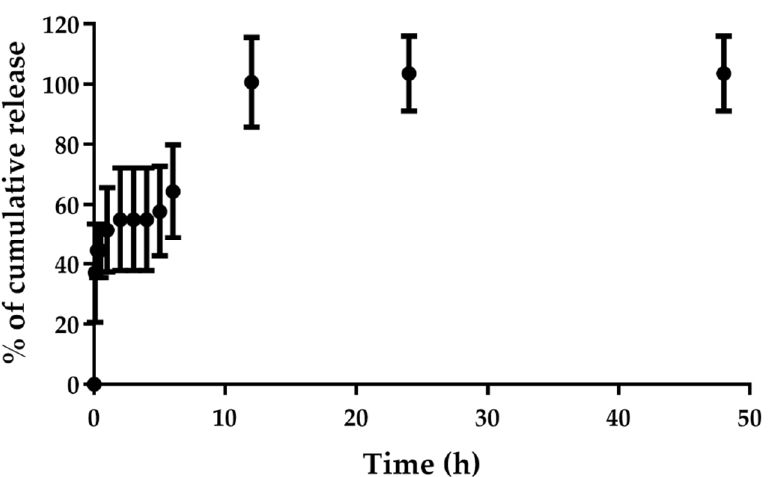
Figure 3. Cumulative release of C 8 from AS1411-gold nanoparticles performed in 20 mM KPi and 100 mM KCl for 48 h ( n = 3). Samples were collected at different time points (0 min, 5 min, 15 min, 30 min, 1 h, 2 h, 3 h, 4 h, 5 h, 6 h, 12 h, 24 h and 48 h).